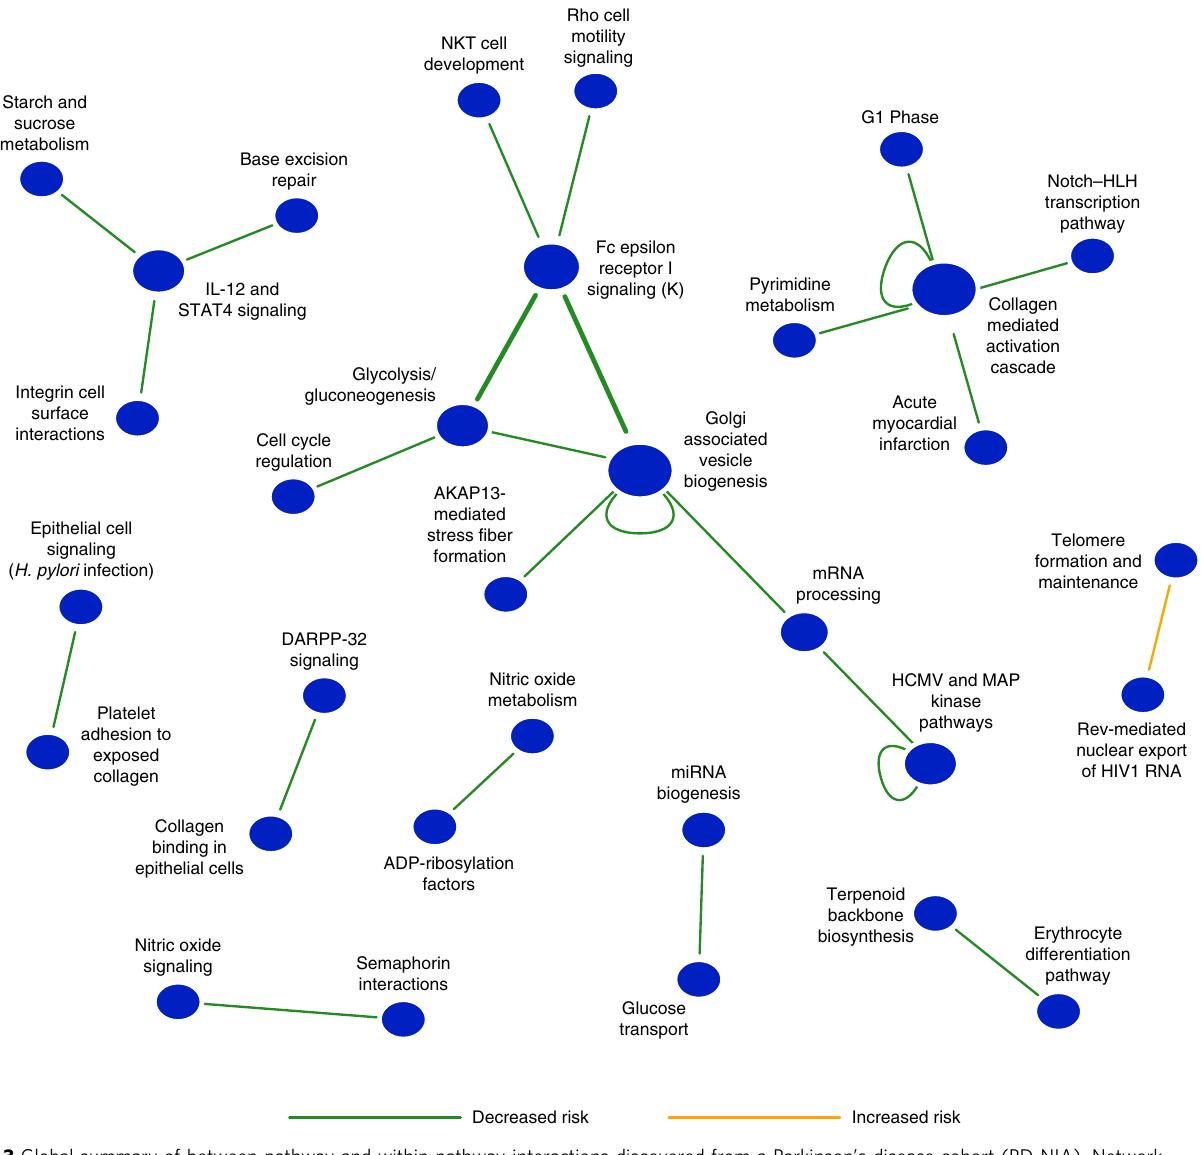
Fig. 3 Global summary of between-pathway and within-pathway interactions discovered from a Parkinson ’ s disease cohort (PD-NIA). Network representation of a set of signi fi cant (FDR ≤ 0.25) between-pathway (BPM) and within-pathway interactions (WPM) that are associated with increased (orange edges) or decreased (green edges) risk of PD. Each node indicates the name of the pathway or gene set, and each edge represents a between- pathway interaction or within-pathway interaction (self-loop edges). The size of the node re fl ects the number of interactions edges it has. Replicated interactions are shown as bold